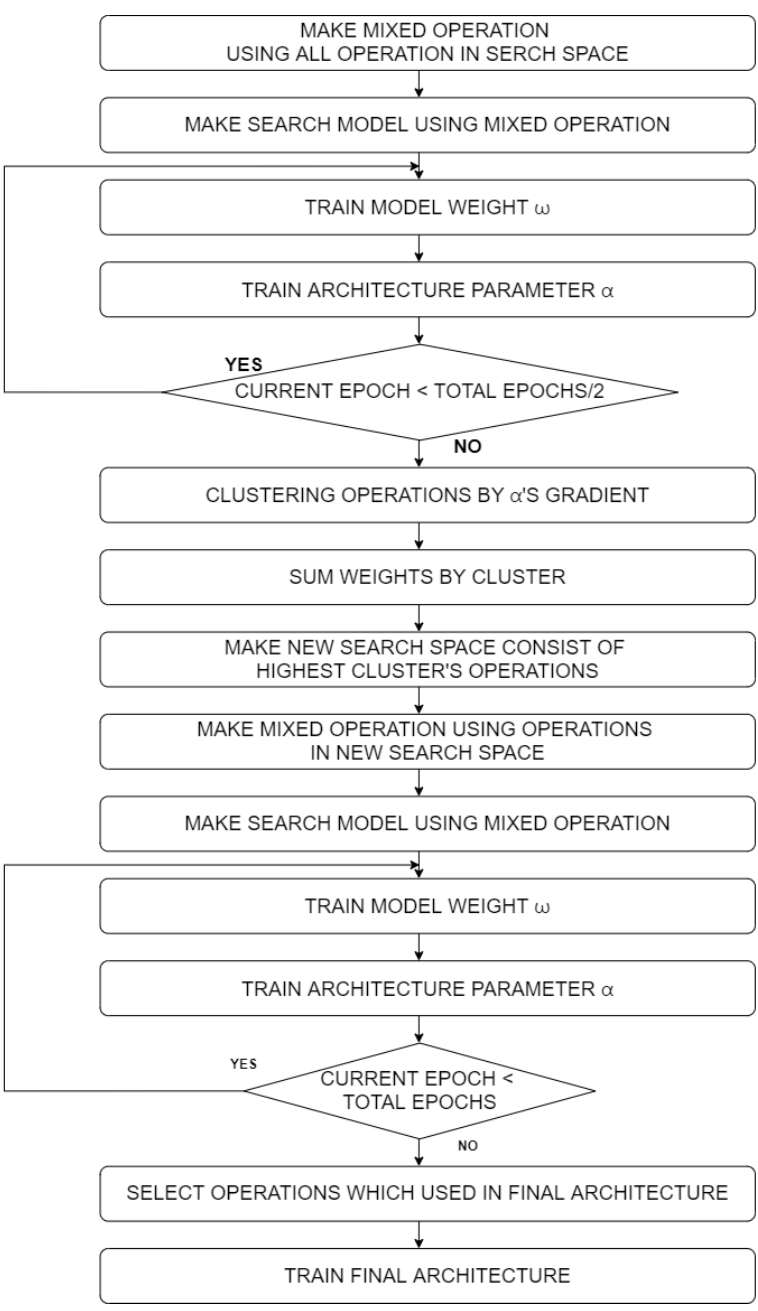
Figure 2. Another view of the DG-DARTS